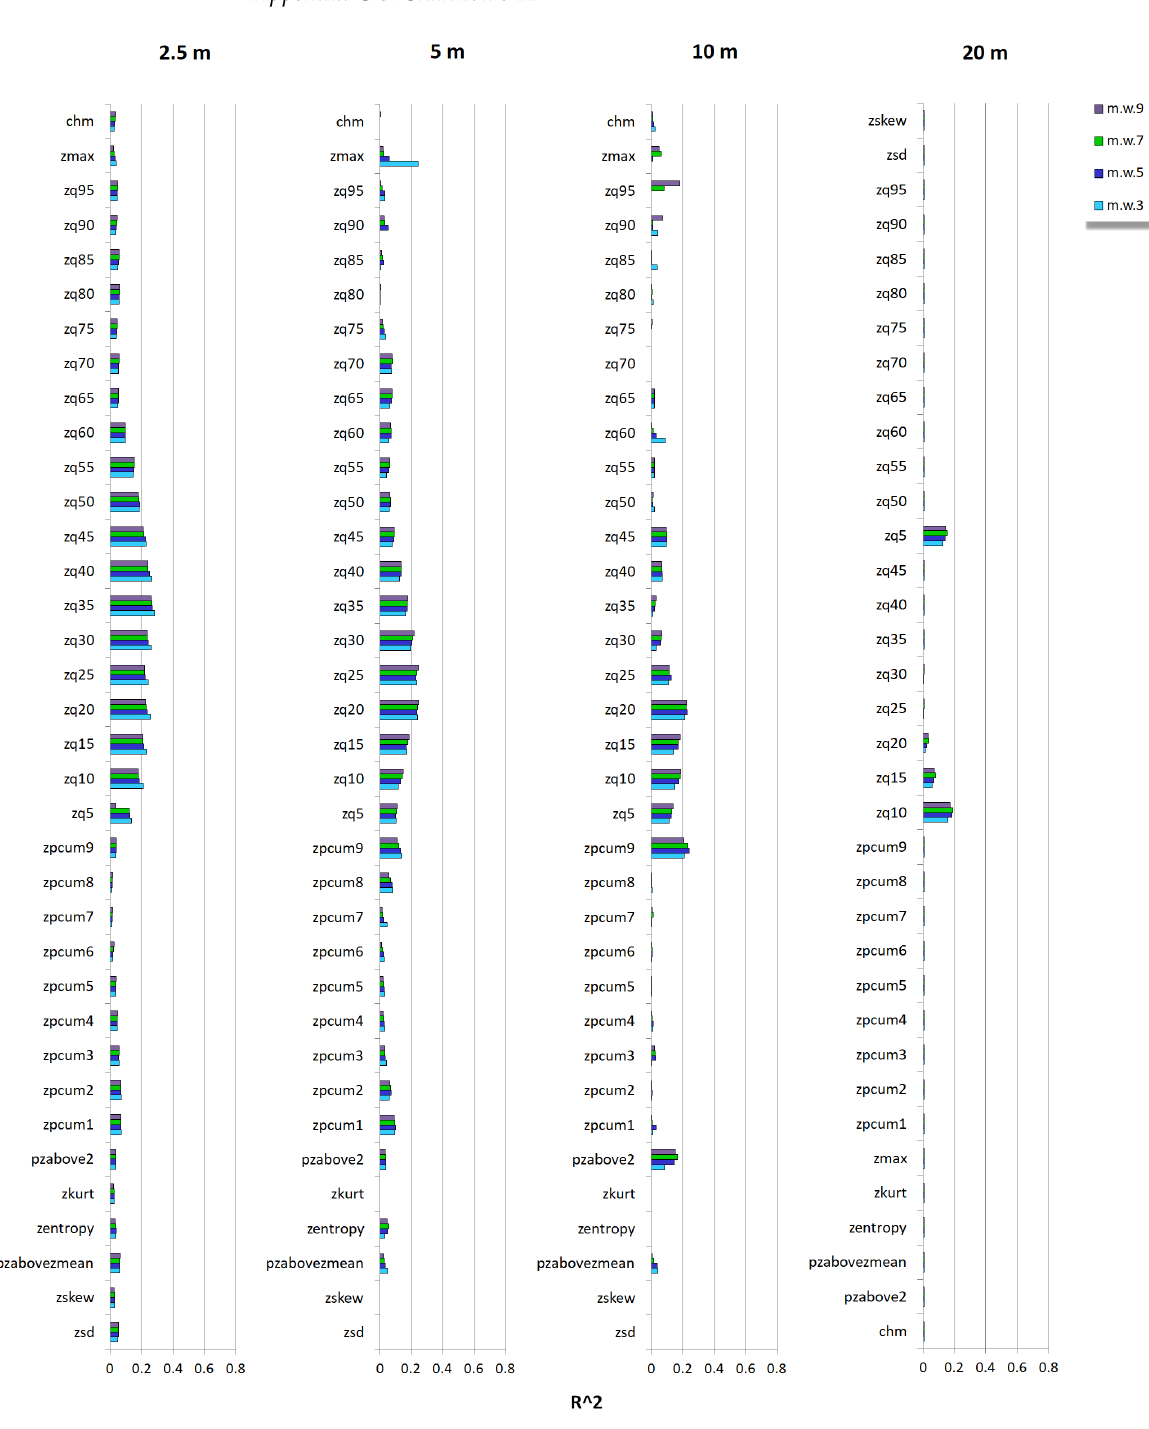
Figure A7. Histograms concerning the R 2 values relative to the linear regression between Shannon’s H field index and the mean of the Shannon’s H matrices of each LiDAR metric and for each MW (San Genesio/Jenesien study